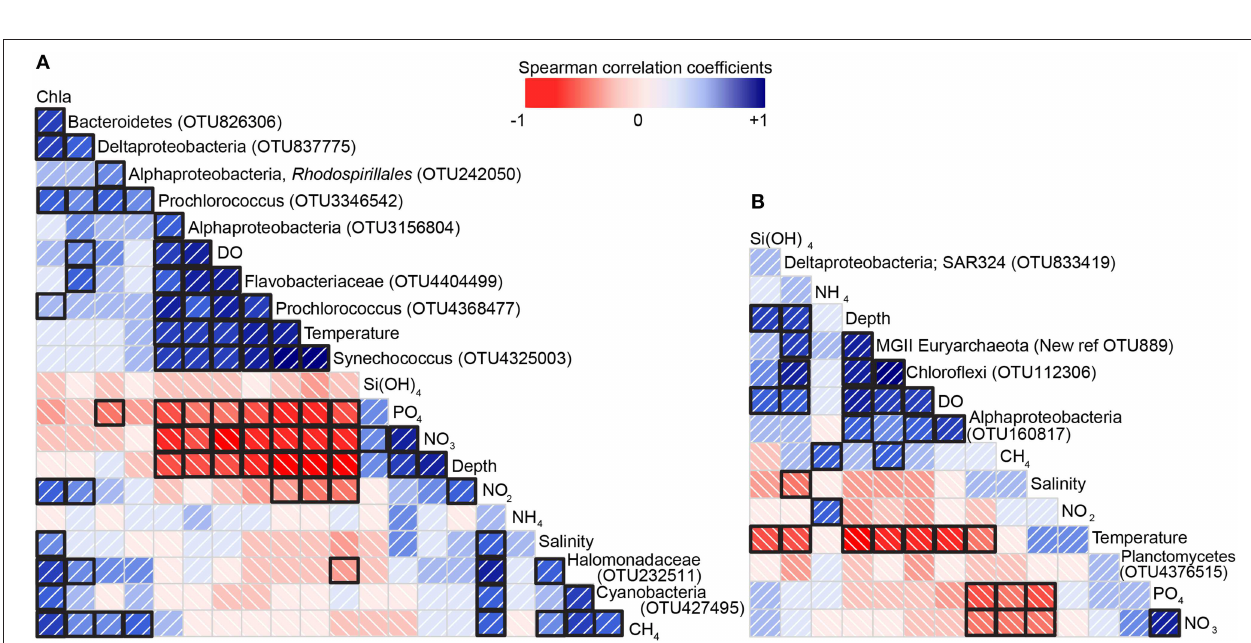
FIGURE 3 | Correlation matrix showing the sign and magnitude of the correlation (Spearman) coefficients between biological, chemical and physical data. (A) Correlation matrix for 0–200m and (B) correlation matrix for 200–2000m. Blue indicates a positive value and red a negative value (see scale bar). The diagonal lines also indicate the direction of the correlation. The intensity of each of these colors increases as the correlation value moves away from zero (see scale bar). Correlations that were statistically significant ( p ≤ 0 . 05 ) are shown by a black square around the borders (e.g., , has a black border indicating a significant correlation vs. , indicating a correlation that was not